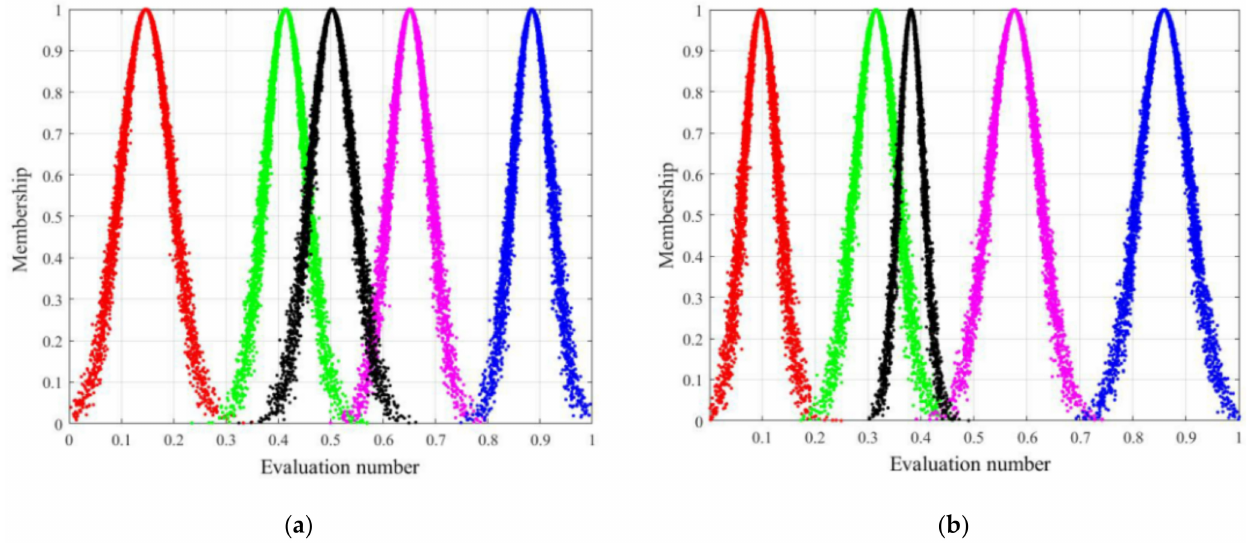
Figure 7. Cloud map of a comprehensive evaluation of first-level indicators; ( a ) mining disturbance; ( b ) geological